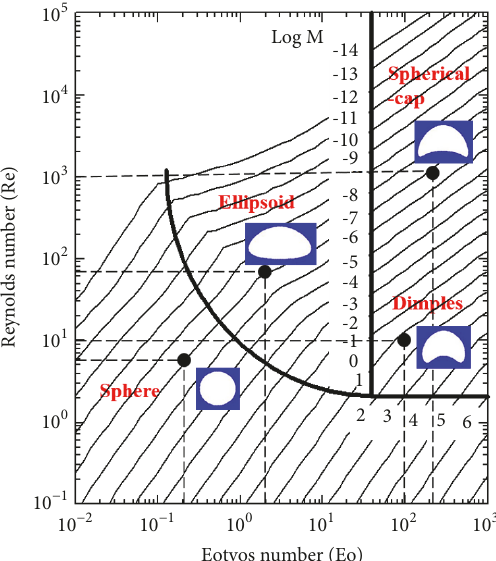
Figure4:Grace’sgraphicalcorrelationforpredictingterminalshape of bubble.